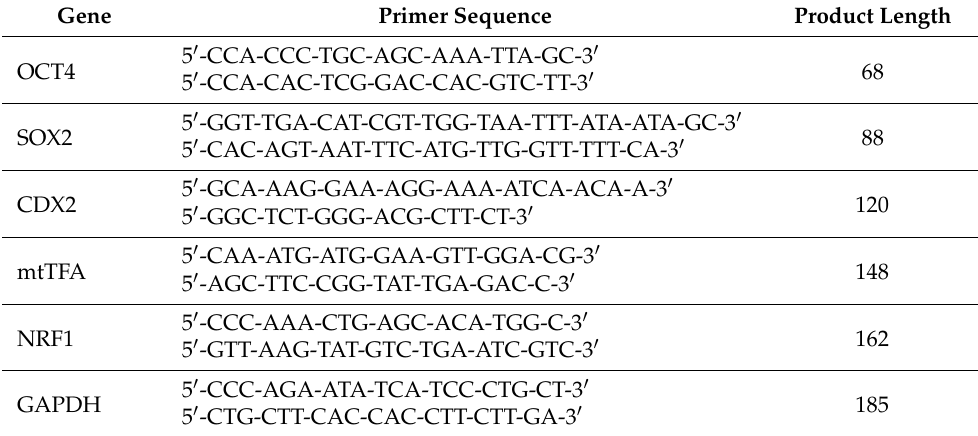
Table 2. Table of forward and reverse primers of genes. Gene Primer